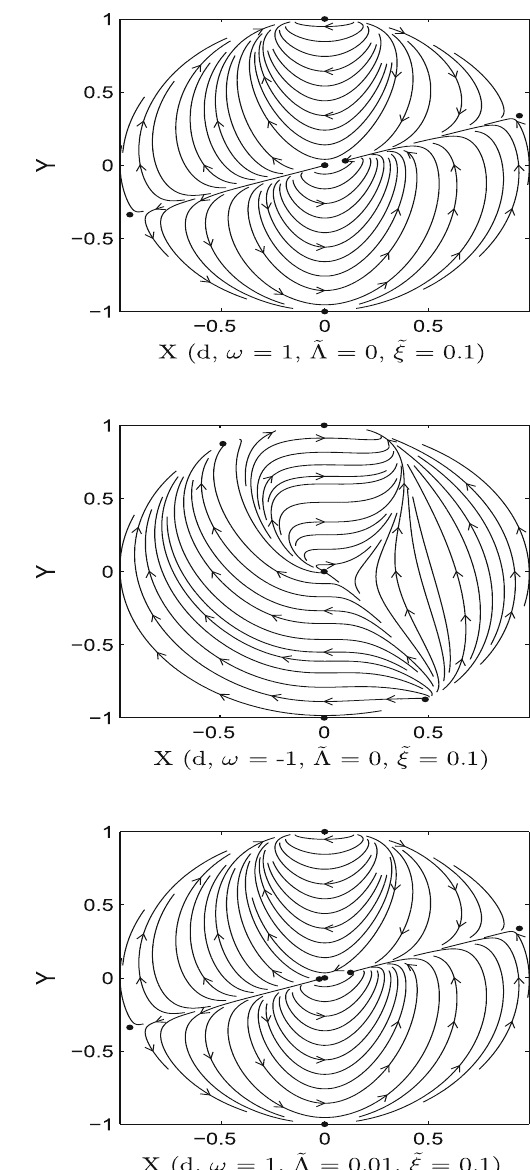
˜ (cid:4), ˜ ξ) given by ˜ (cid:4), ˜ ξ) into five